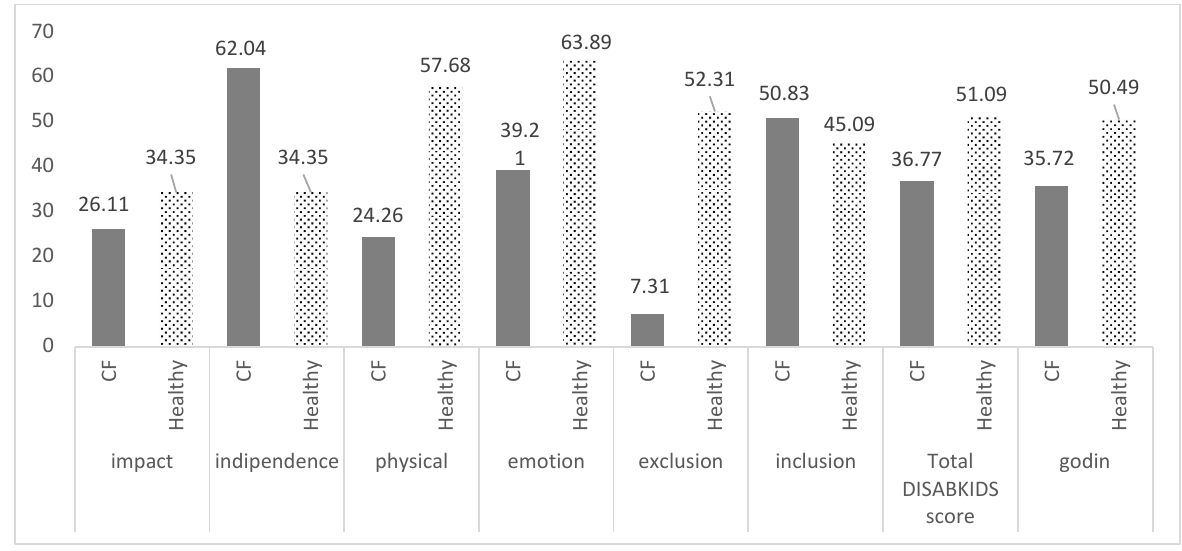
Figure 1. Physical activity (Godin Questionnaire) among pwCF and healthy controls.